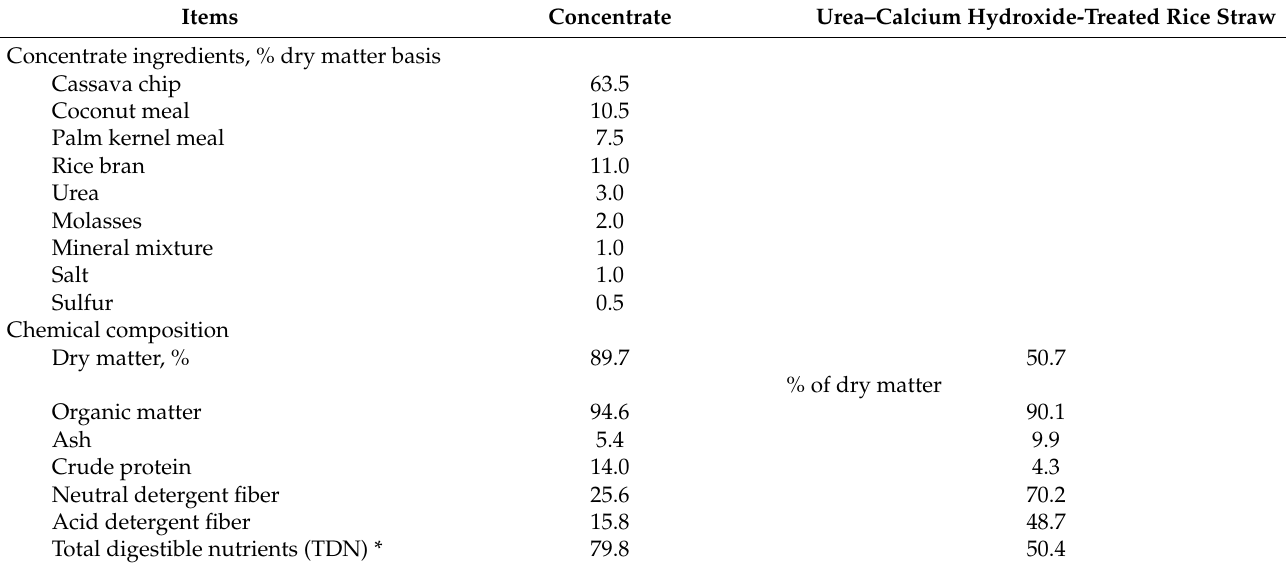
Table 1. Compositions of concentrate mixtures and urea–calcium hydroxide-treated rice